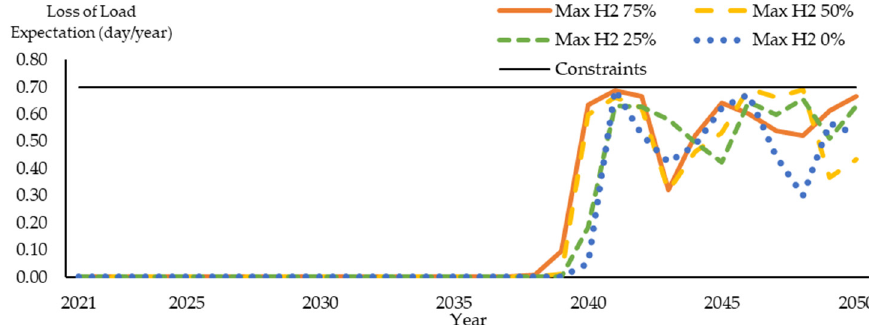
Figure 19. Loss of load expectation comparison.